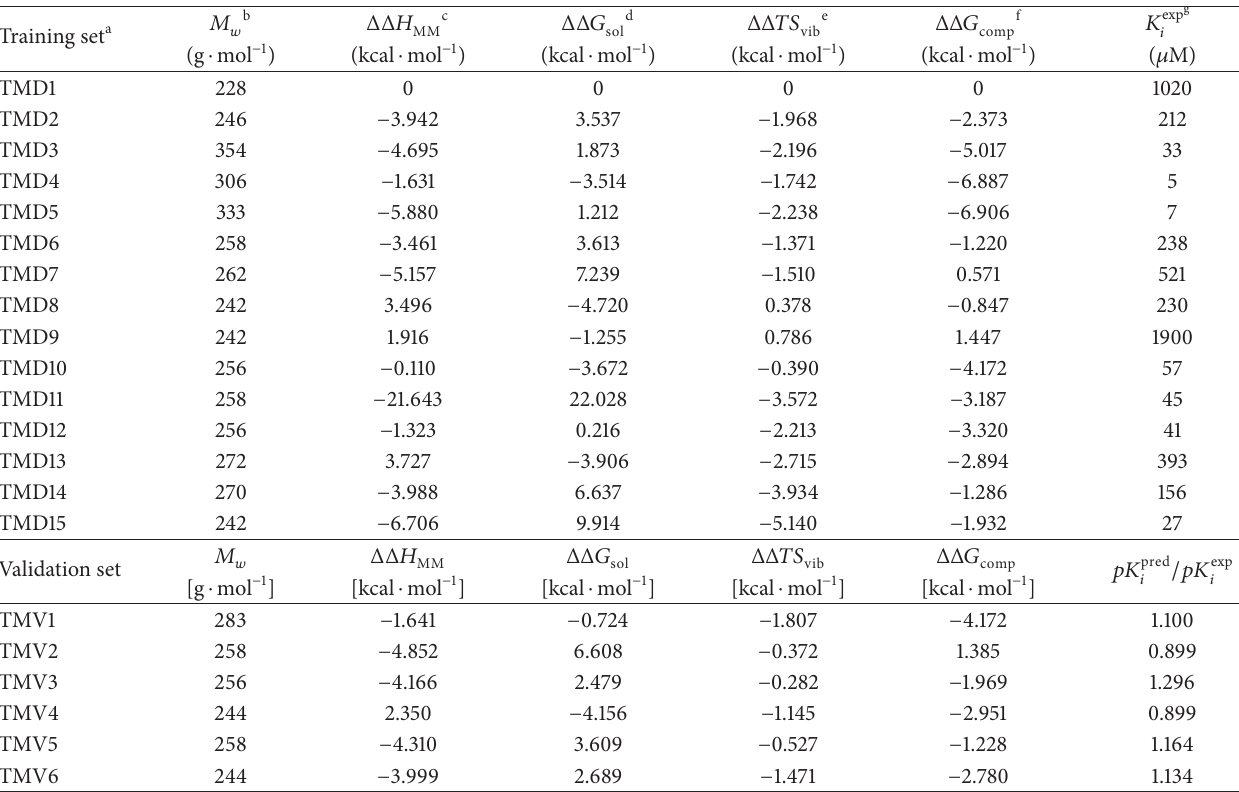
Table 2: Complexation energy and its components for the training set of TMPK mt inhibitors: TMD1–TMD15. Training set a